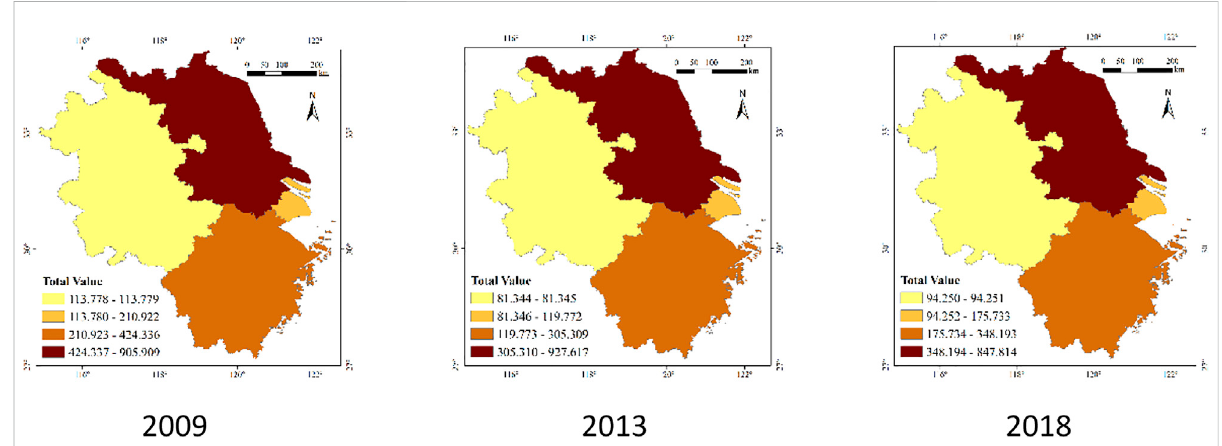
FIGURE 4 Spatial variation of the total water ESV in the Yangtze River Delta region from 2009 to 2018. Note: The unit of the total water ESV is 100 million